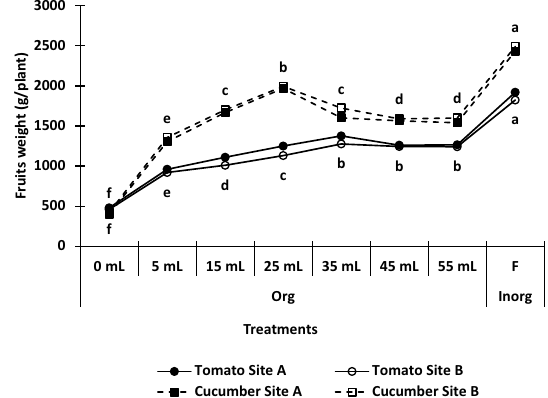
Figure 2. Effect of organic and in-organic fertilizers on fruit weight of tomato and cucumber under soilless medium. Values followed by similar letters under the same graph are not significantly different at p = 0.05